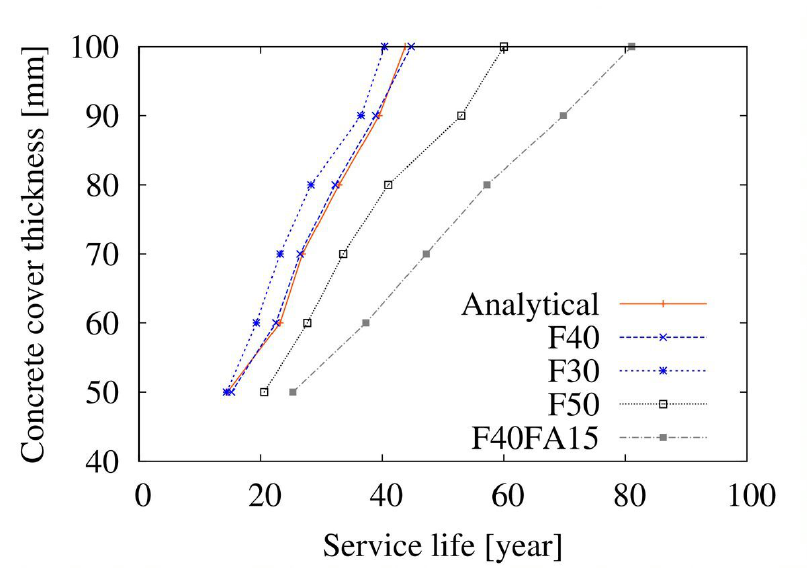
Fig. 11. The relationship between the service life and the concrete cover thickness of the coastal RC